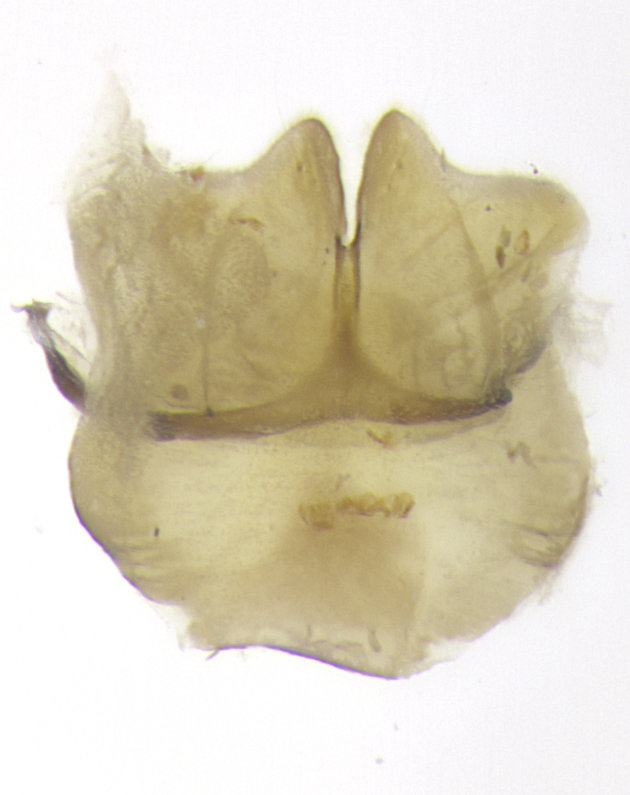
sternite 5, ventral view.